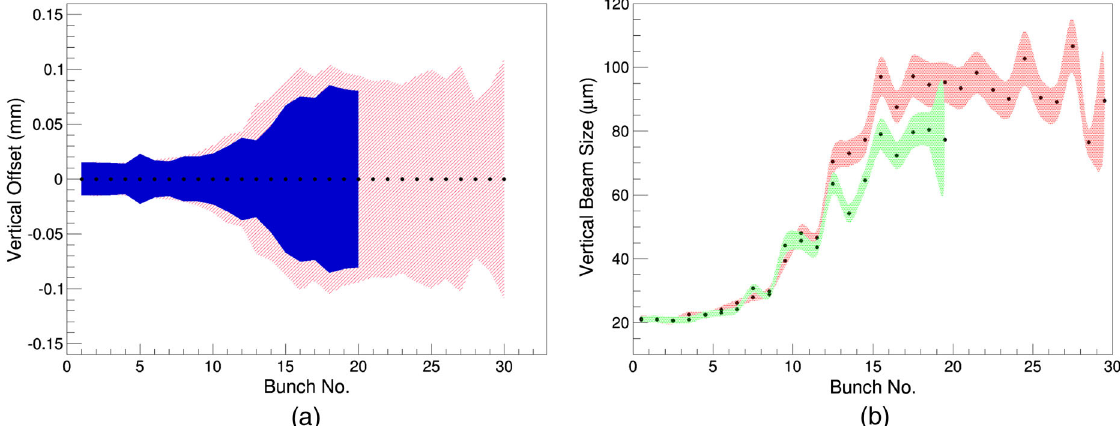
FIG. 9. Vertical bunch (a) motion and (b) size as a function of bunch number for two train lengths. (Shaded ¼ RMS amplitude with vertical feedback off, dots ¼ mean value.)